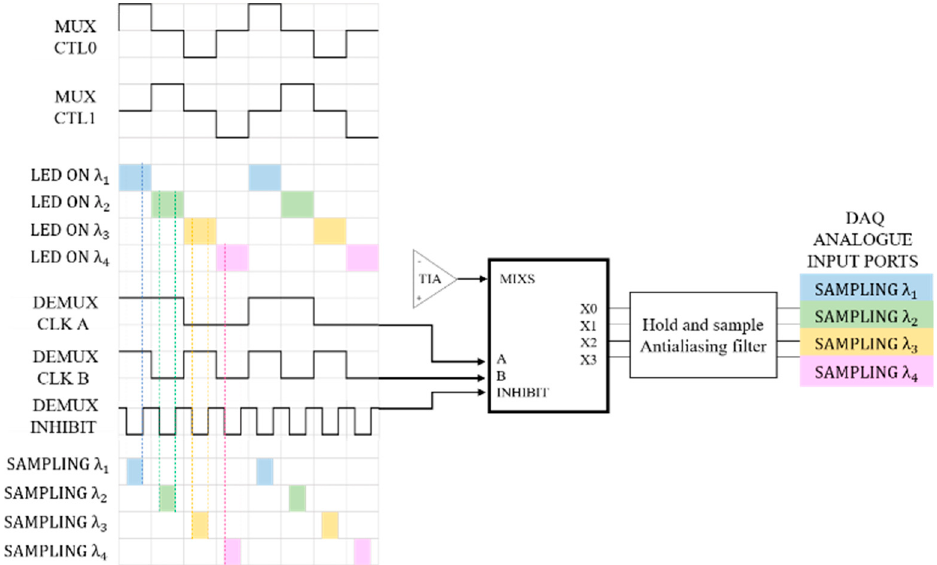
Figure 4. LEDs multiplexing and photodetectors’ signals demultiplexing. Each color box represents a wavelength.